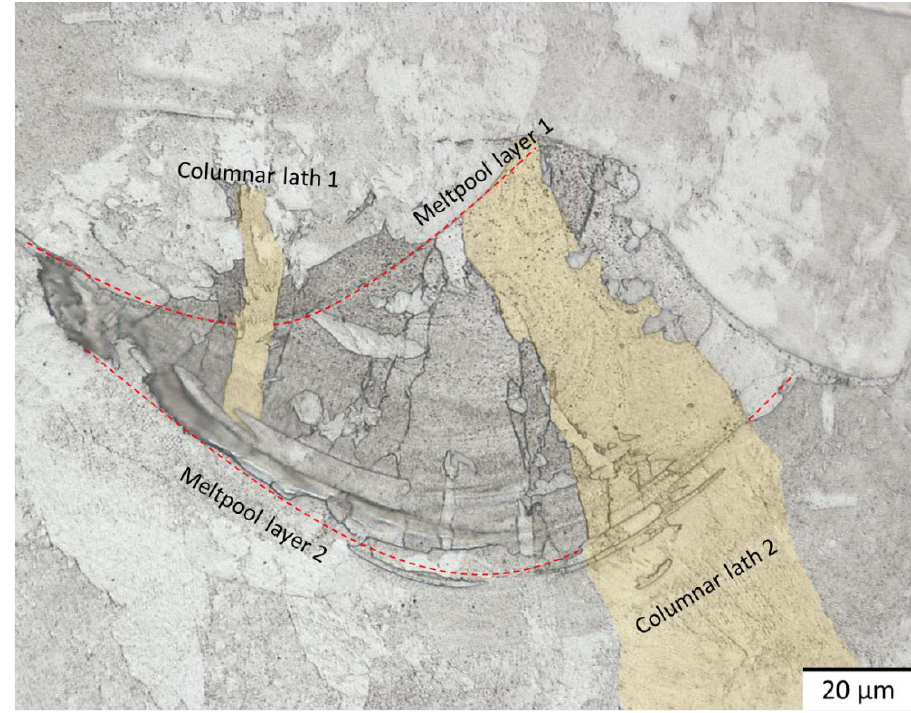
Figure 10. Columnar lath generation acress multiple meltpools.